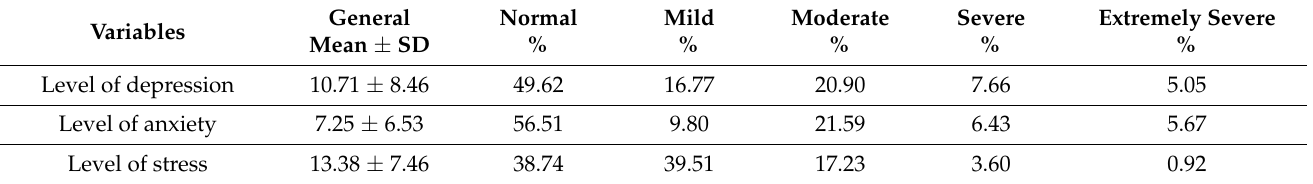
Table 2. Evaluation of the psychiatric symptoms: depression, anxiety, and stress among Poles (n =